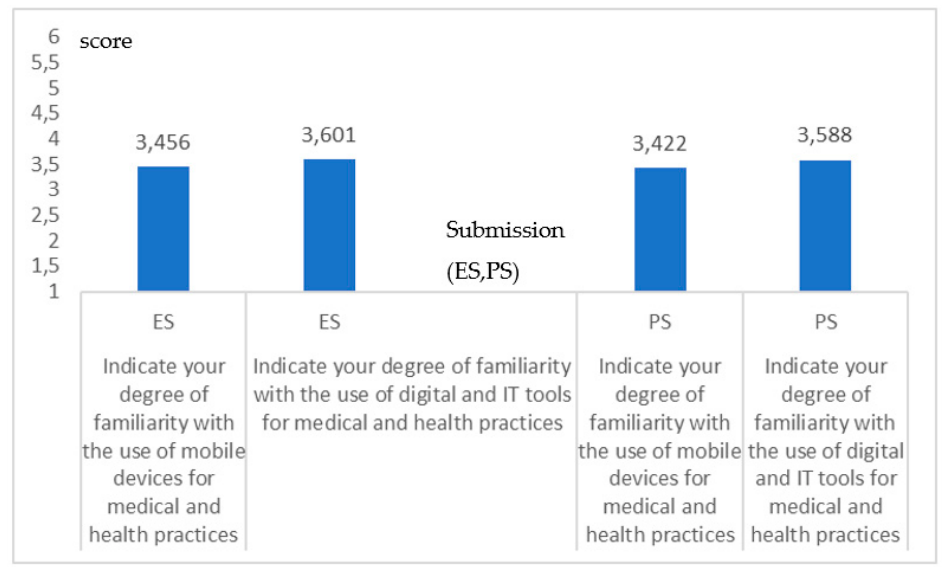
Figure 5. Coherence in the degree of familiarity assessment with mHealth ( p = 0.333) processes and the Digital Health ( p = 0.291) both for the ES and PS. The graphic indicates a high coherence between the two groups.